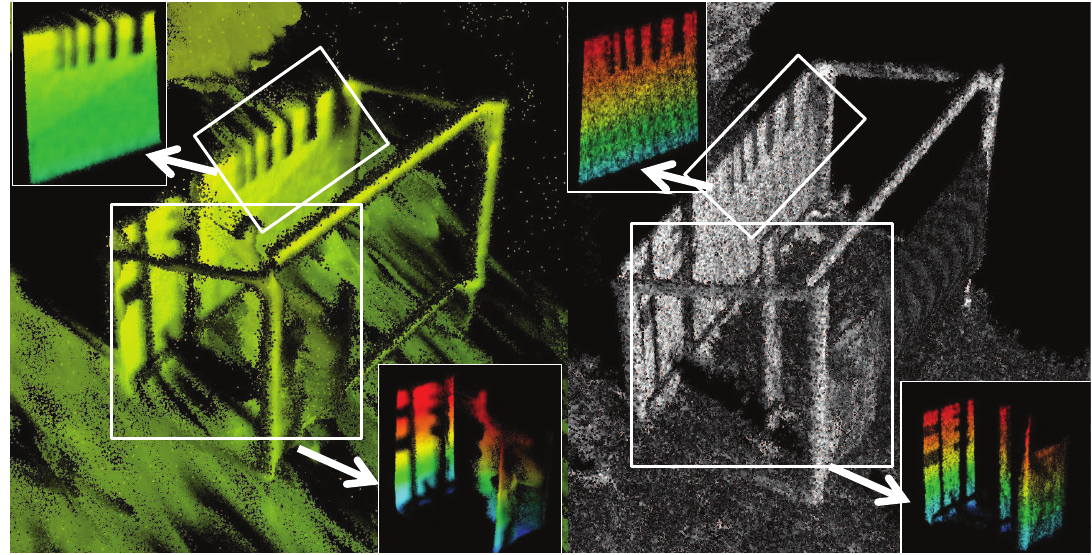
Figure 4: (Top) Point clouds of Target 2 from (left) VZ-400 and (right) HRS-3D. Insets show chosen point cloud subsets for further analysis.